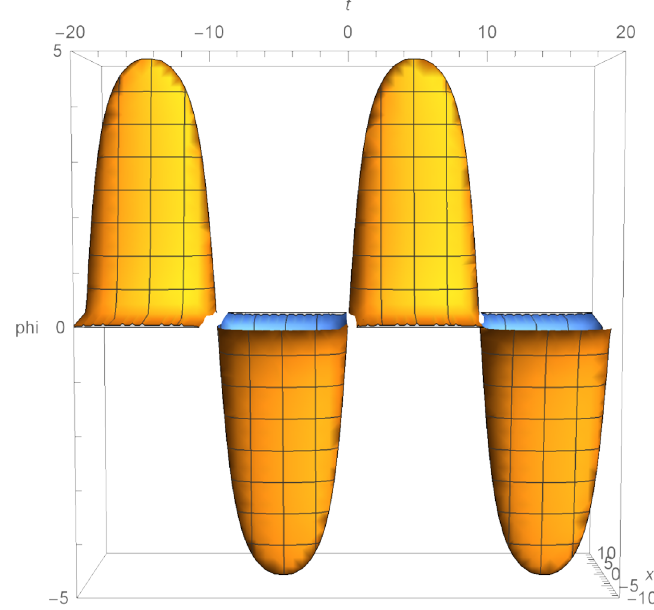
Figure 7 . The undeformed breather solution for µ = 1 , β = 1 , tan ψ = 2 π/ 5 . which is true for the usual breather (at λ = 0 ). Thus in effect we have ˙ φ → ˙ φ/ (1 − 2 λV